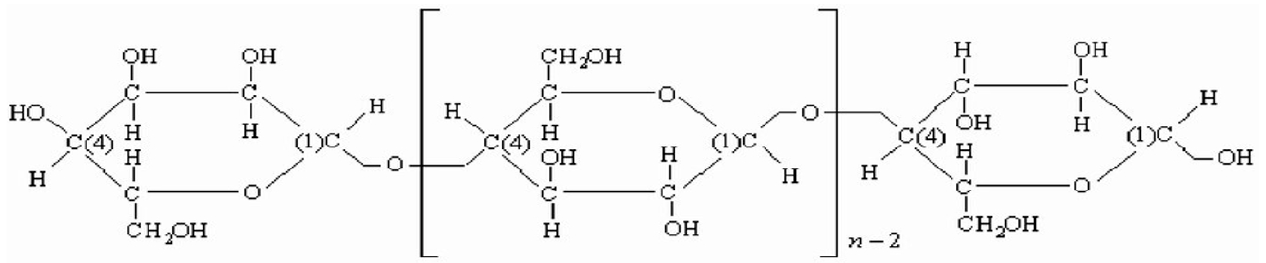
Figure 5. Chemical structure of cellulose molecule formula.